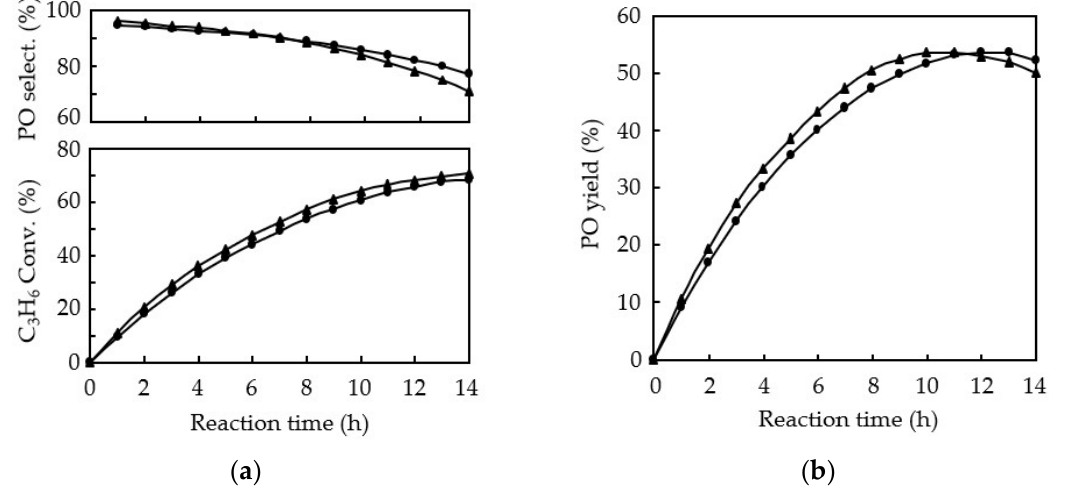
Figure 2. Effect of reaction time in the propylene epoxidation by O 2 in methanol at 363 K over Pd-PW-HAP and Pd+PW 2 . (●): Pd-PW-HAP; ( ▲ ): Pd+PW 2 . ( a ) Effects of C 3 H 6 conversion and PO selectivity; ( b ) effect of PO yield. Reaction conditions: same as those in Table 2.